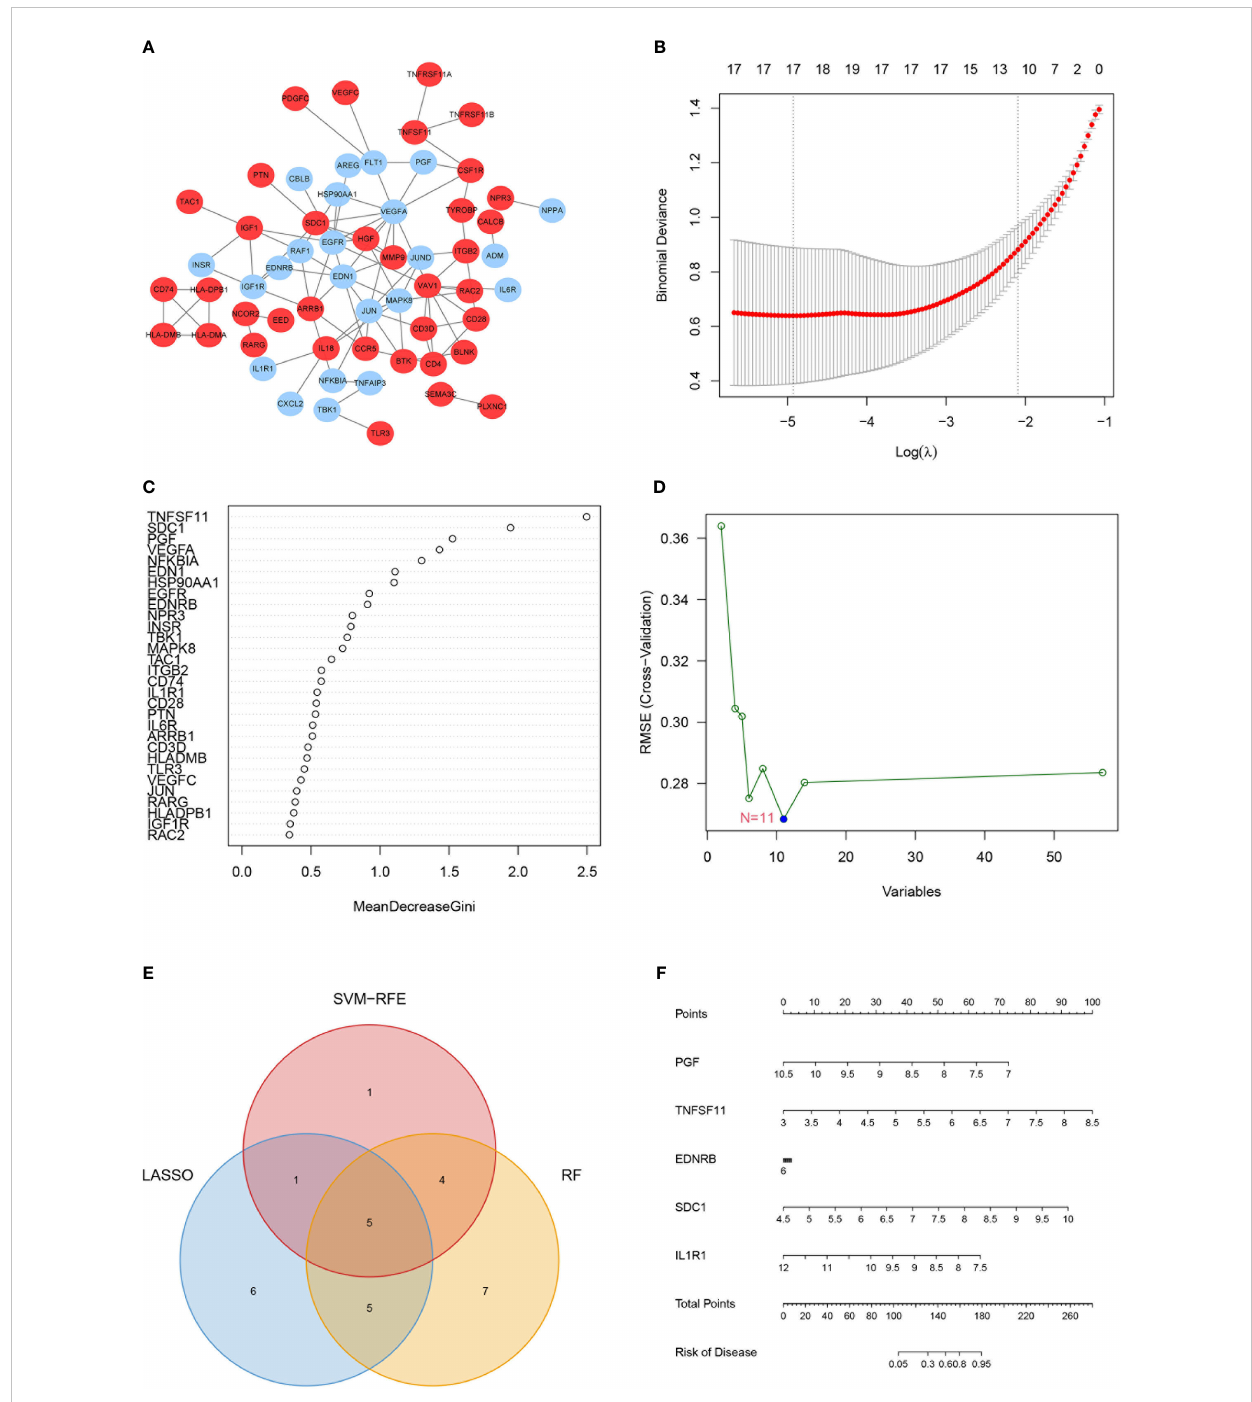
FIGURE 2 Hub immune-related genes (IRGs) and their diagnostic value. (A) Protein – protein interaction network of the IRGs. (B – D) Hub IRGs were fi ltered by three machine learning strategies of feature selection, including least absolute shrinkage and selection operator (B) , random forest (C) , and support vector machine (D) . (E) Five hub IRGs were identi fi ed by the three machine learning strategies. (F) The fi ve-IRG-based nomogram model showed good diagnostic